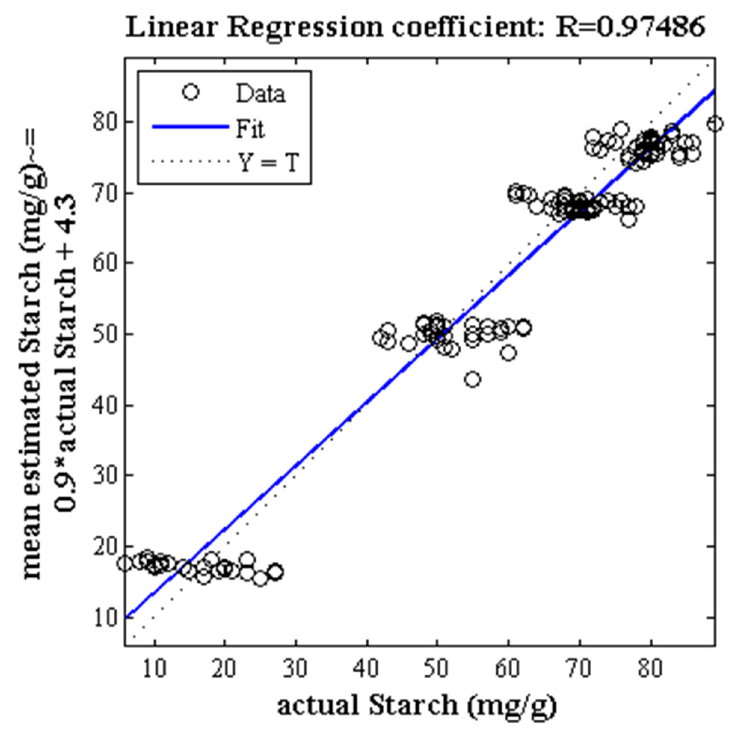
Figure 3. Regression analysis of the scatter plot between the mean estimated and the measured starch content in Fuji apple based on spectral data of 800 to 900 nm.